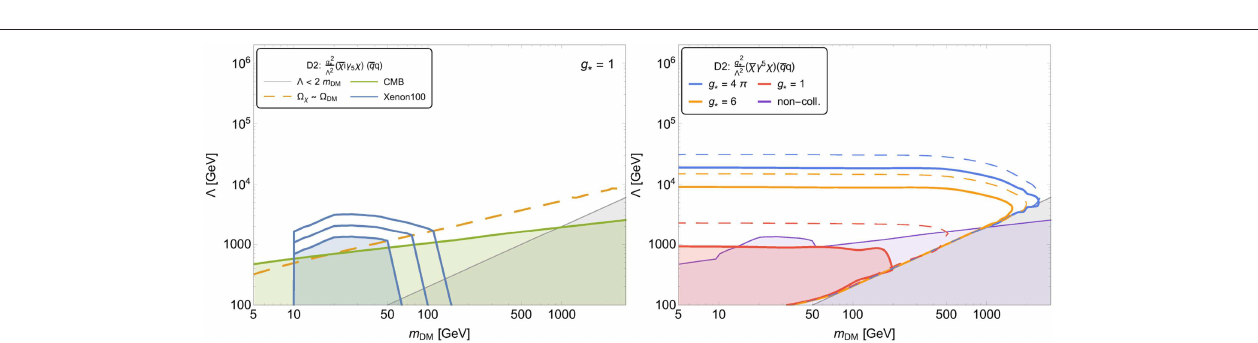
FIGURE 2 | Invariant mass of DM pair distributions normalized to unity for EFT operators in Table 1 for 13 TeV LHC energy, M DM applied.